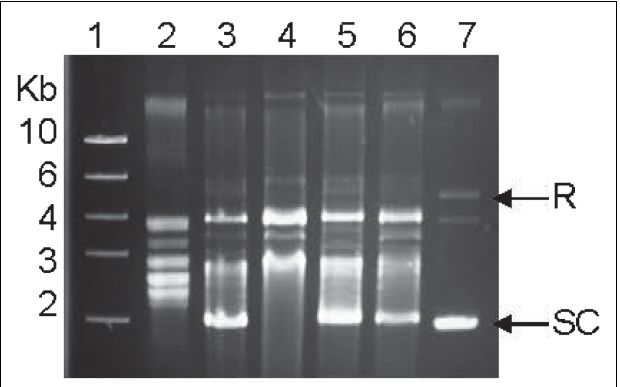
FIGURE 2 | Supercoiling activities of the recombinantWT gyrase and the three recombinant mutant gyrases measured by an in vitro assay. Lane 1, DNA ladder; Lane 2, relaxed pBR322 (control); Lane 3,WT GyrA + GyrB; Lane 4, mutant GyrA (Thr-86-Ile) + GryB; Lane 5, mutant GyrA (Thr-86-Lys) + GryB; Lane 6, mutant GyrA (Asp-90-Asn) + GryB; and Lane 7, supercoiled pBR322 (control). SC indicates supercoiled DNA and R represents relaxed